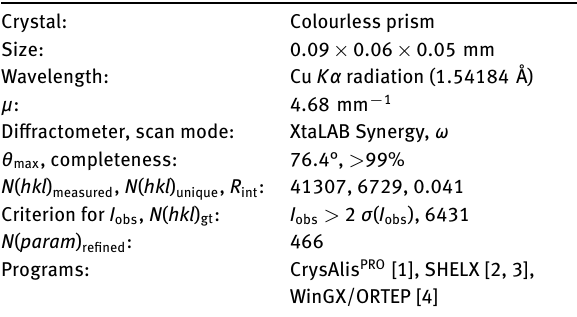
Table 1: Data collection and